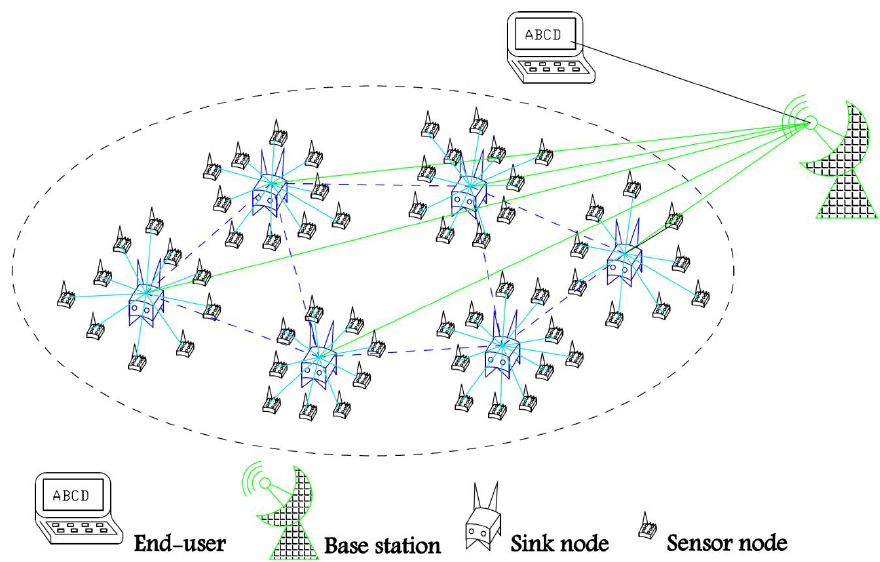
Figure 1. Schematic Diagram of the Network Model.